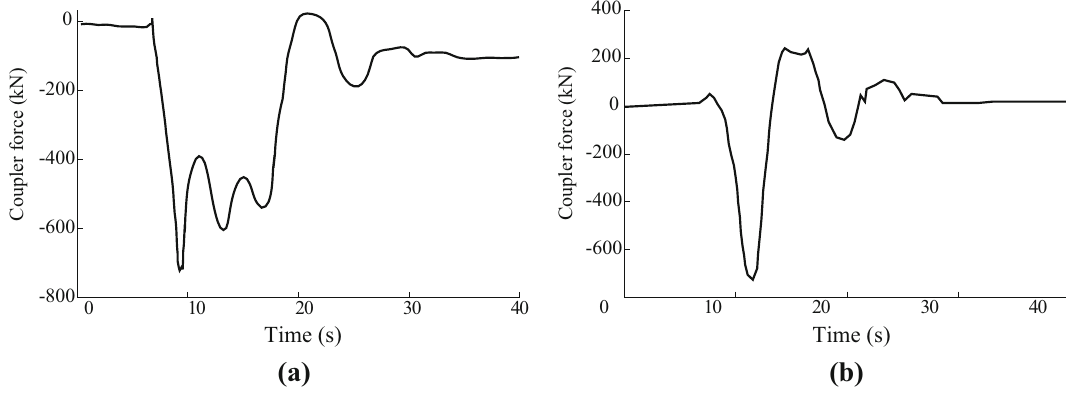
Fig. 3 Measured in-train forces of train to train rescue scenarios. a CRH2E–CRH1B. b